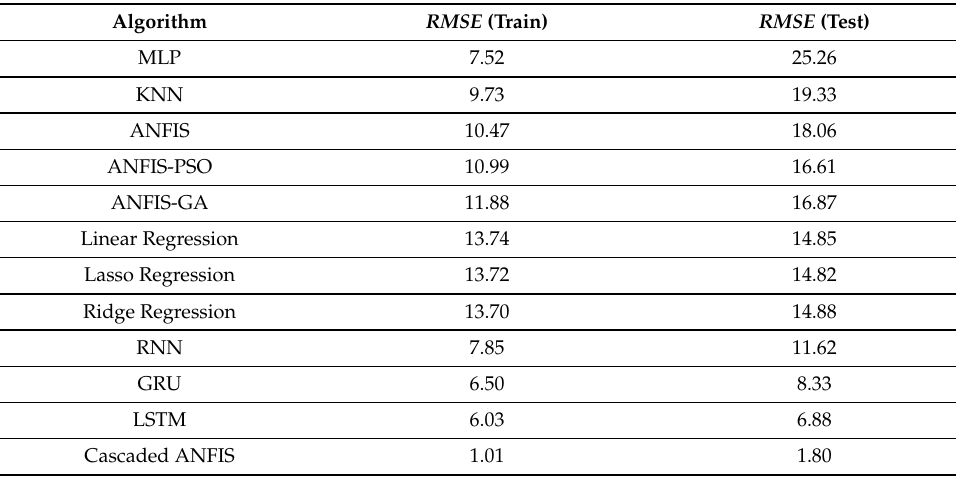
Figure 5. Coefficients of Determination ( R 2 ) of Rain Fall Test dataset for ( a ) linear regression, ( b ) lasso regression, ( c ) ridge regression ( d ) RNN, ( e ) LSTM, and ( f ) GRU. Table 3. RMSE for training and testing